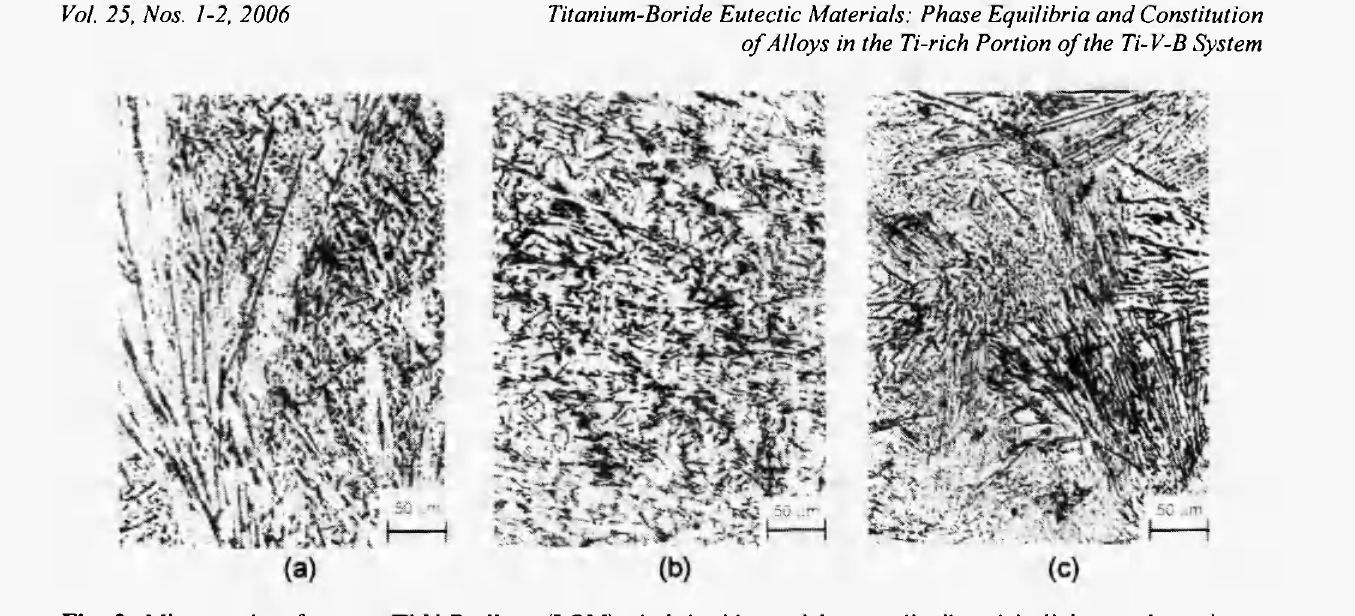
Fig. 2: Micrographs of as-cast Ti-V-B alloys (LOM), dark boride particles are distributed in light metal matrix: a,